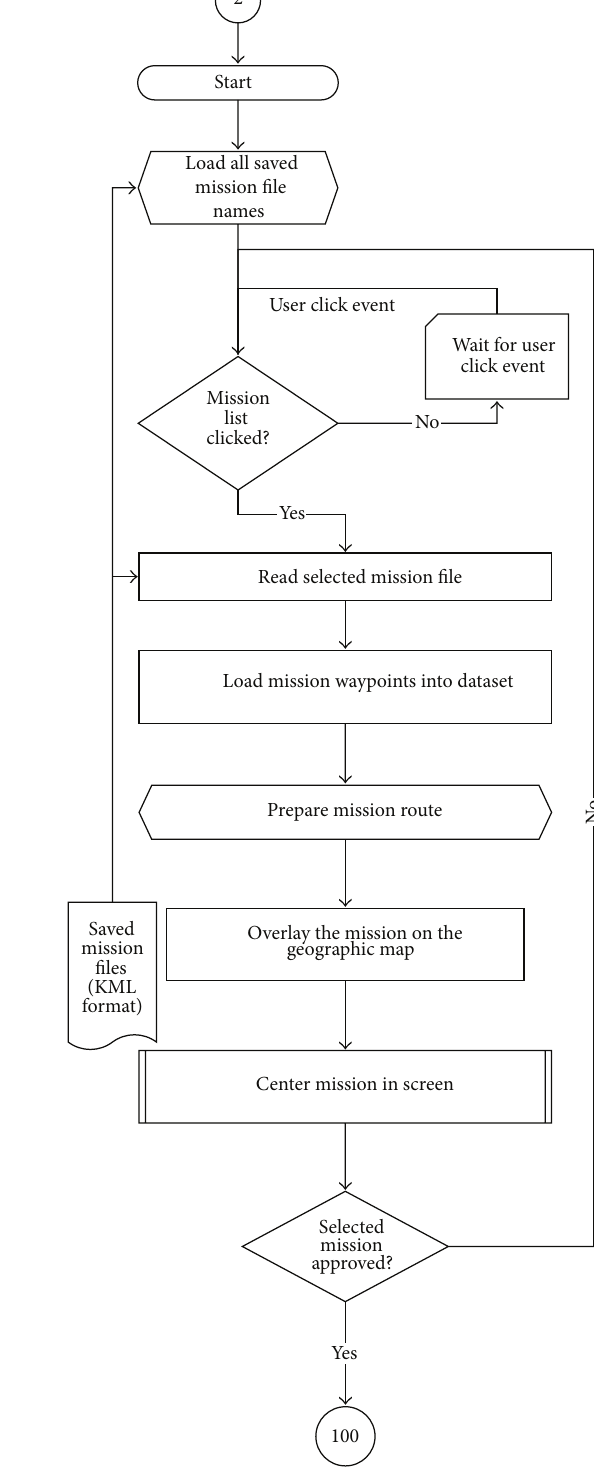
Figure 3: Proposed mission viewer flowchart.